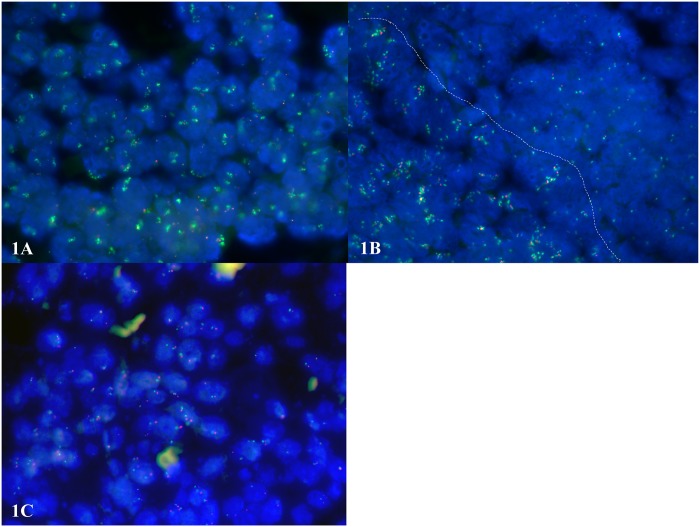
FISH analysis in ESCC patients.Green signals represent the FGFR1 gene while red signals correspond to the centromere of chromosome 8. (A) high-level amplification of FGFR1 showing 10–20 gene signals and 2–4 centromere signals with a ratio of 6.16. (B) Heterogeneous amplification of FGFR1 as indicated by presence of two distinct cancer areas with FGFR1 amplification and without FGFR1 amplification. These two areas are separated by the dotted line. (C) Normal FGFR1 gene and centromere 8 signals.